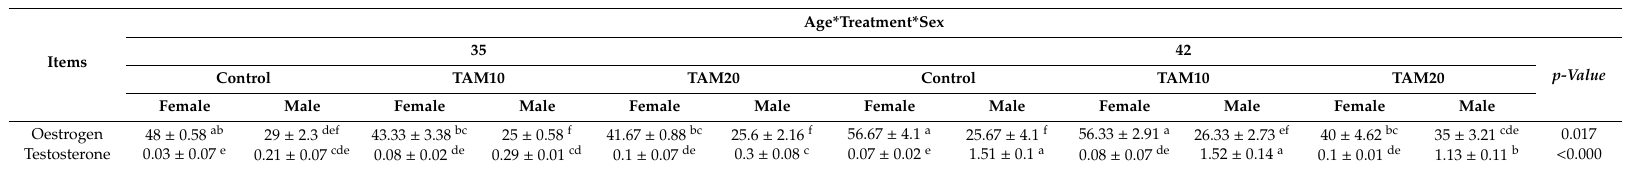
Table 8. E ff ects of interaction between age, Tamoxifen treatment and sex on serological concentrations of oestrogen and testosterone in broilers.